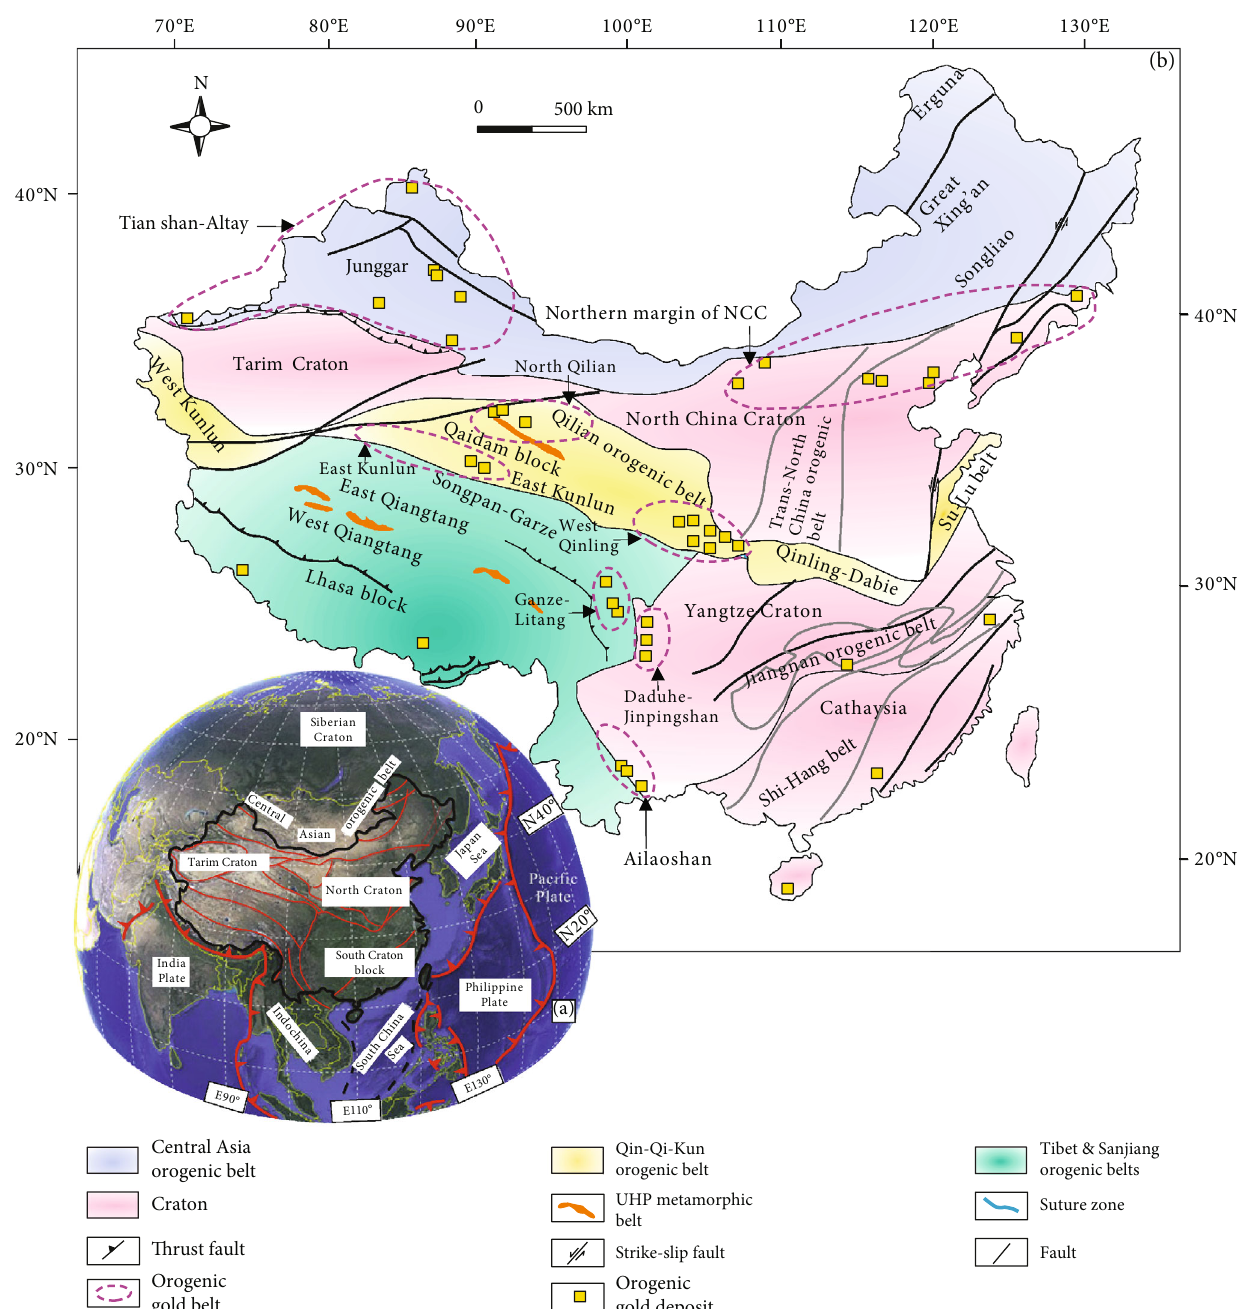
Figure 1: (a) Distribution of major continental blocks and oceanic plates around China, based on Google Earth. (b) Space-time distribution of investigated gold deposits in mainland of China (modi fi ed after Deng and Wang